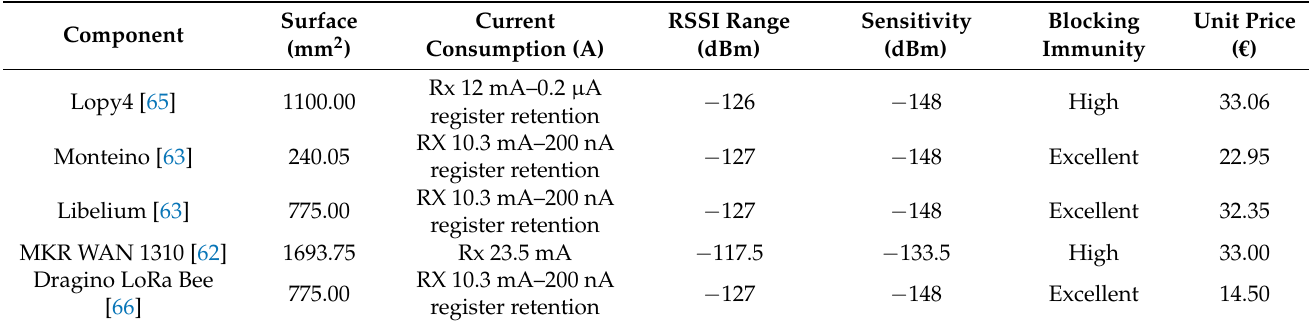
Table 2. Comparison of LoRa end-devices.